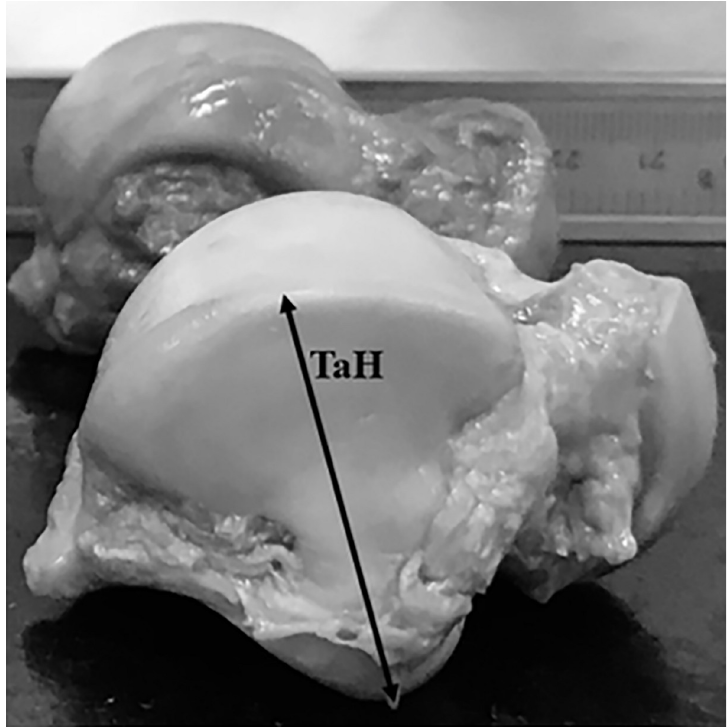
Fig 3. Abbreviations: Talar dome height (TaH).